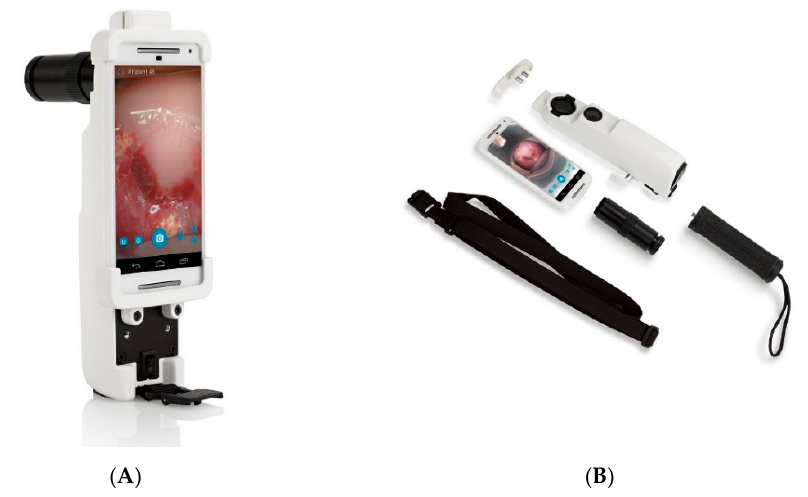
Figure 1. Photos of the Enhanced Visual Assessment (EVA) System’s mobile colposcope, either assembled ( A ), or split into its various components ( B ).